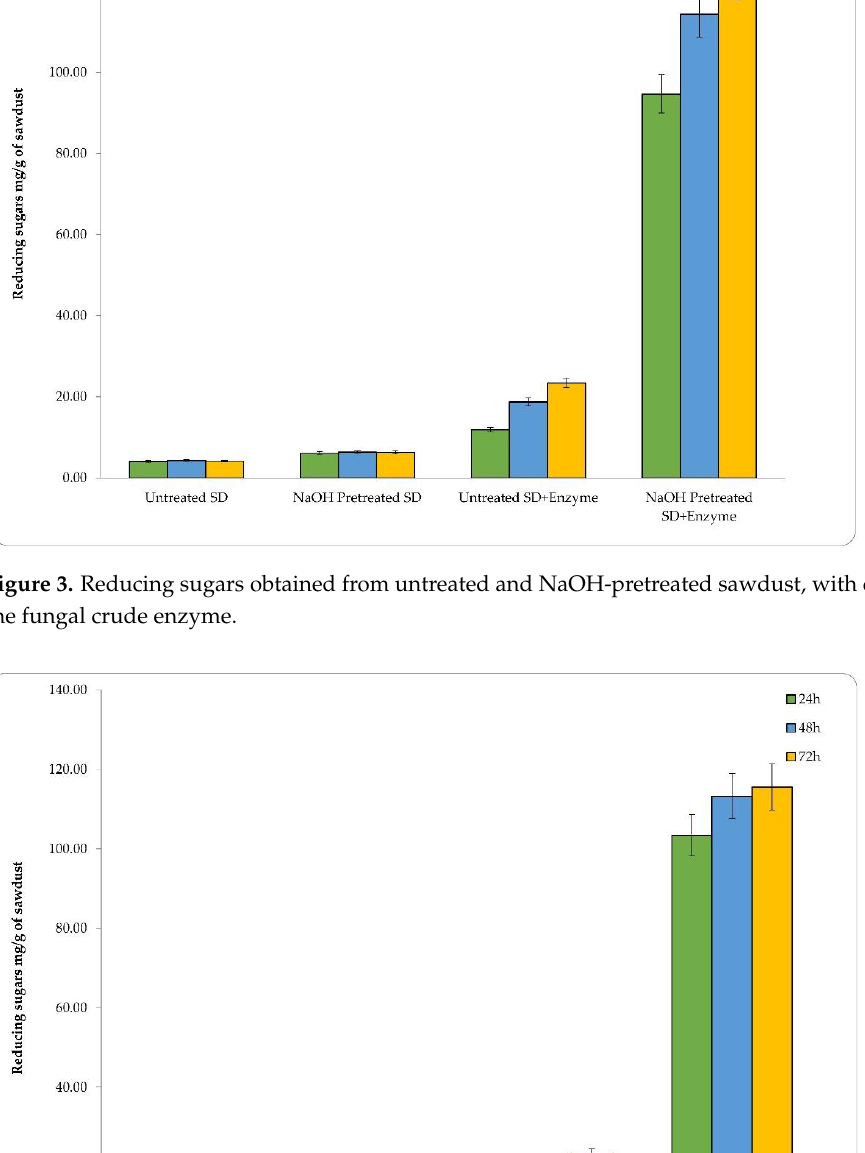
Figure 2. Reducing sugars obtained from untreated and NaOH-pretreated wheat straw, with or without the fungal crude enzyme.